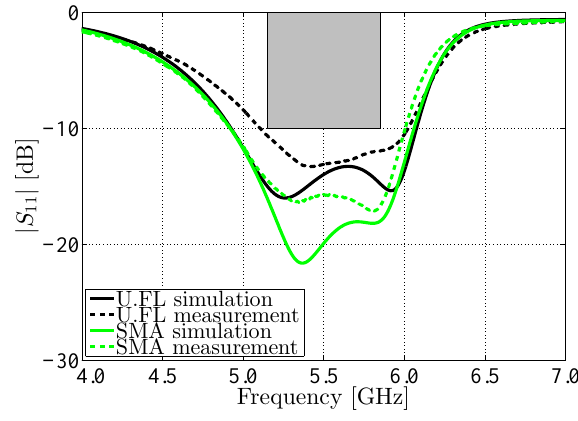
Figure 9. Magnitude of the reflection coefficient | S 1,1 | of the measured antennas in free space, with respect to a 50 Ω reference impedance.